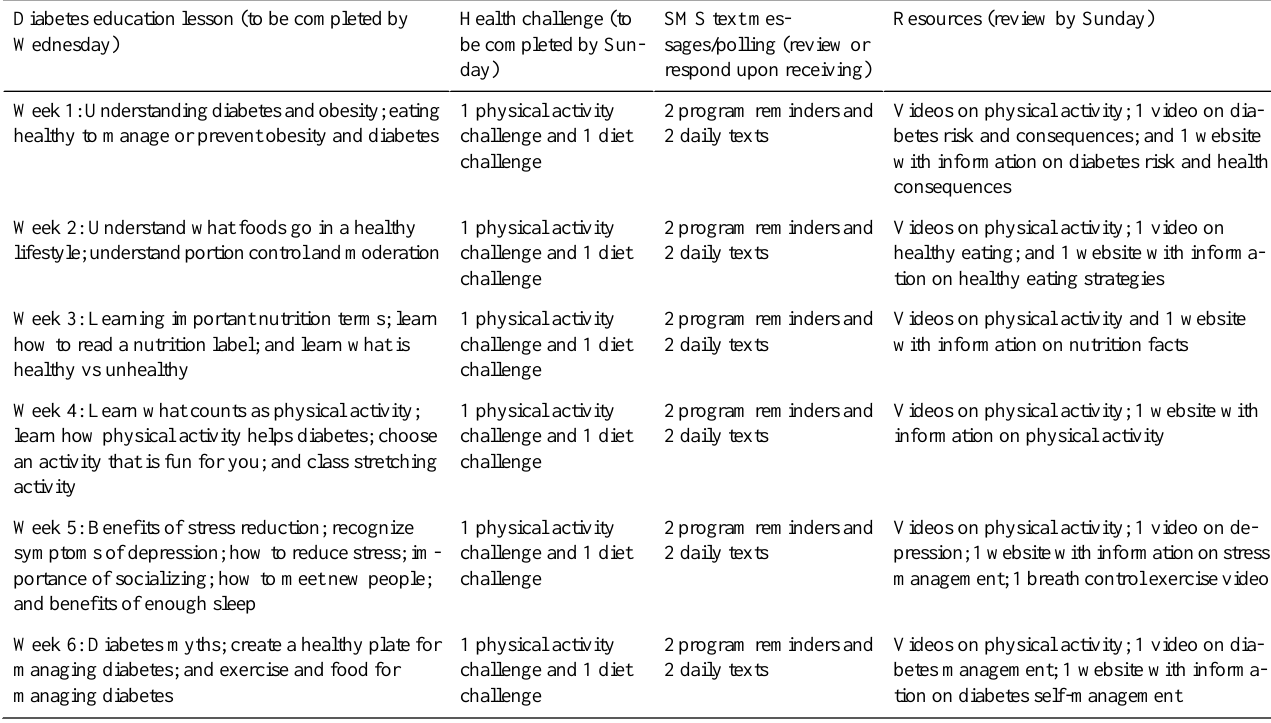
Table 2. Mobile Health Diabetes Education Program